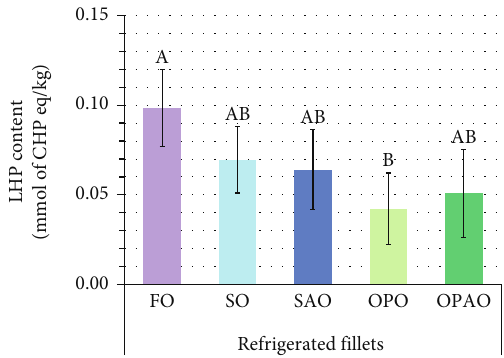
Figure 1: Primary oxidation of refrigerated fi llets: lipid hydroperoxide content (obtained after an incubation time of 30 min) from the fi ve dietary treatments of interest. The results were represented as mean ± standard deviation ( n = 5 ) of CHP concentrations (mmol/kg). The di ff erences between dietary treatments found in refrigerated fi llets with Sche ff é ’ s post hoc ( n = 25 ) were noted as A > B. Abbreviations: For diet abbreviations (FO, SO, SAO, OPO, and OPAO), see Table 2; LHP: lipid hydroperoxide; CHP: cumene